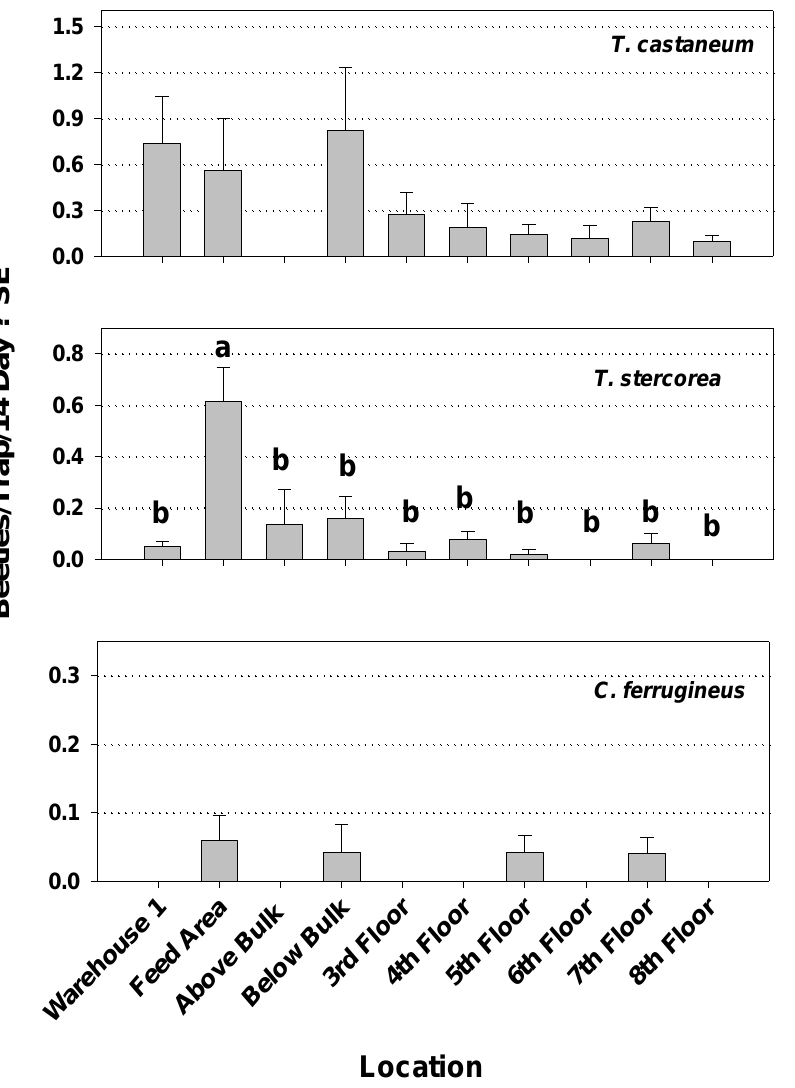
Figure 2. Capture of the three most commonly trapped beetle pests by locations within mill 1 during Year 1. Results are from 13 biweekly observations from 34 pitfall traps. Capture of Tribolium castaneum was not significantly different by location ( F = 1.77; df = 9, 25; p = 0.1241). There was a significant difference in capture of Typhaea stercorea ( F = 10.90; df = 9, 25; p = 0.0001). Capture of Cryptolestes ferrugineus was not significantly different by location ( F = 1.57; df = 9, 25; p = 0.1791). Mean captures of T. stercorea with the same letter are not significantly different.